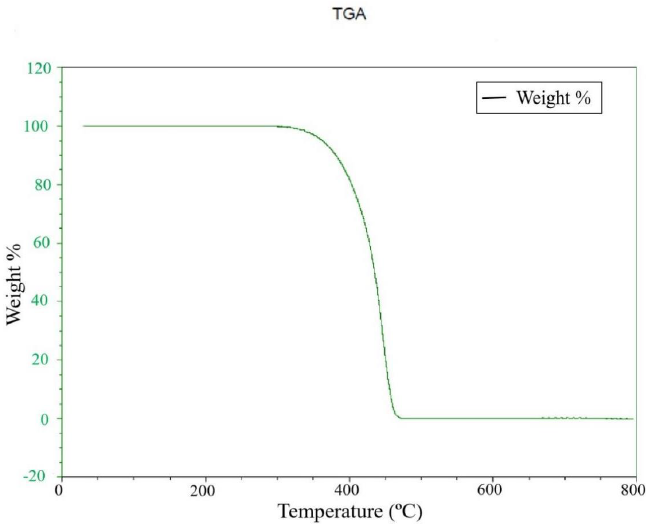
Figure 5. Thermogravimetric analysis of PP.